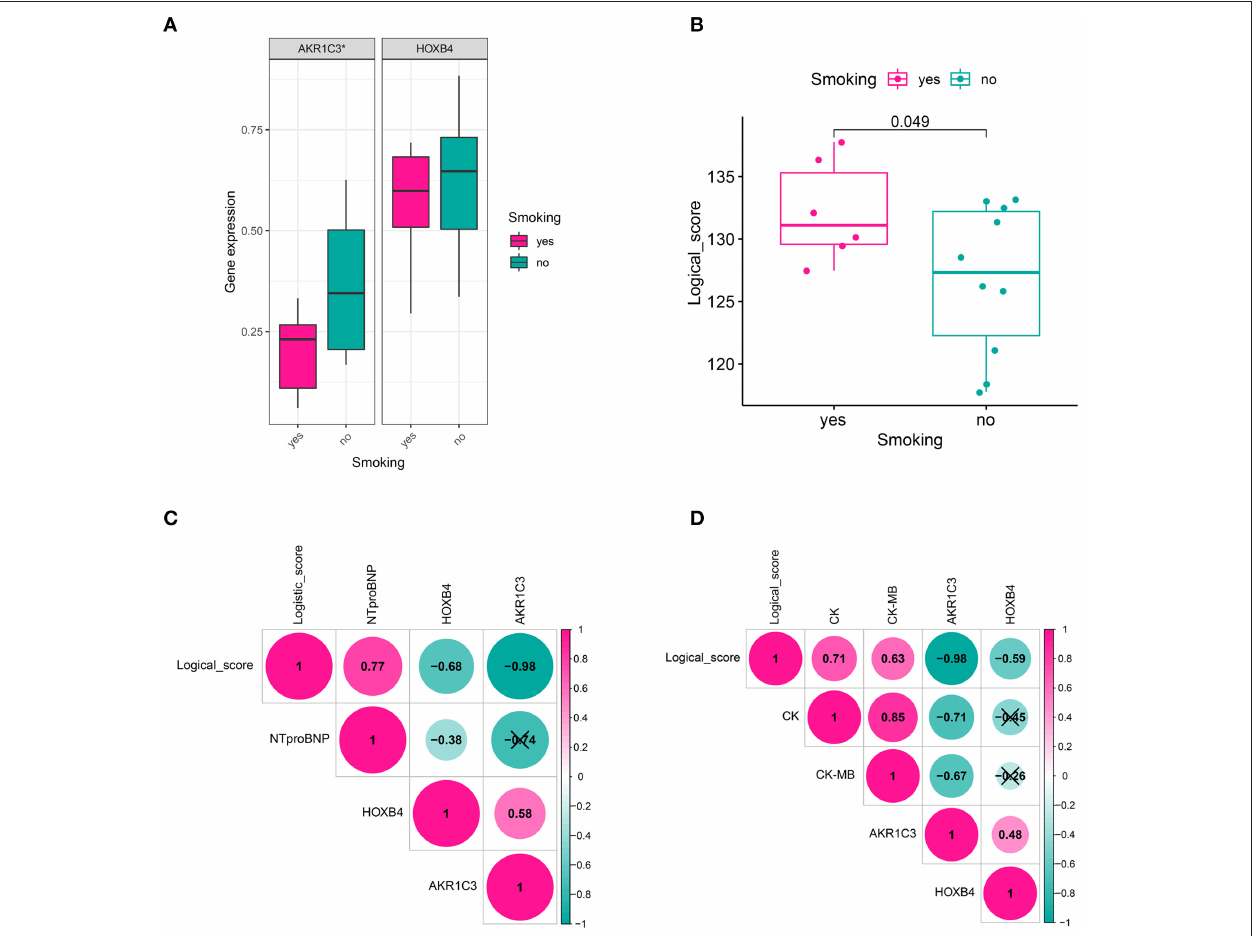
FIGURE 8 | Clinical relevance. (A) AKR1C3 was downregulated in acute myocardial infarction (AMI) patients with smoking history. (B) The cases with smoking history had a higher logical score, which meant that these people were more likely to be diagnosed as AMI. (C) HOXB4 and the logical score were significantly correlated with the value of NTproBNP. (D) AKR1C3 and the logical scores had a significant association with CK and CK-MB. NTproBNP, N-terminal-pro-B-type natriuretic peptide; CK, creatine kinase; CK-MB, creatine kinase MB fraction; * p < 0.05. ns, not